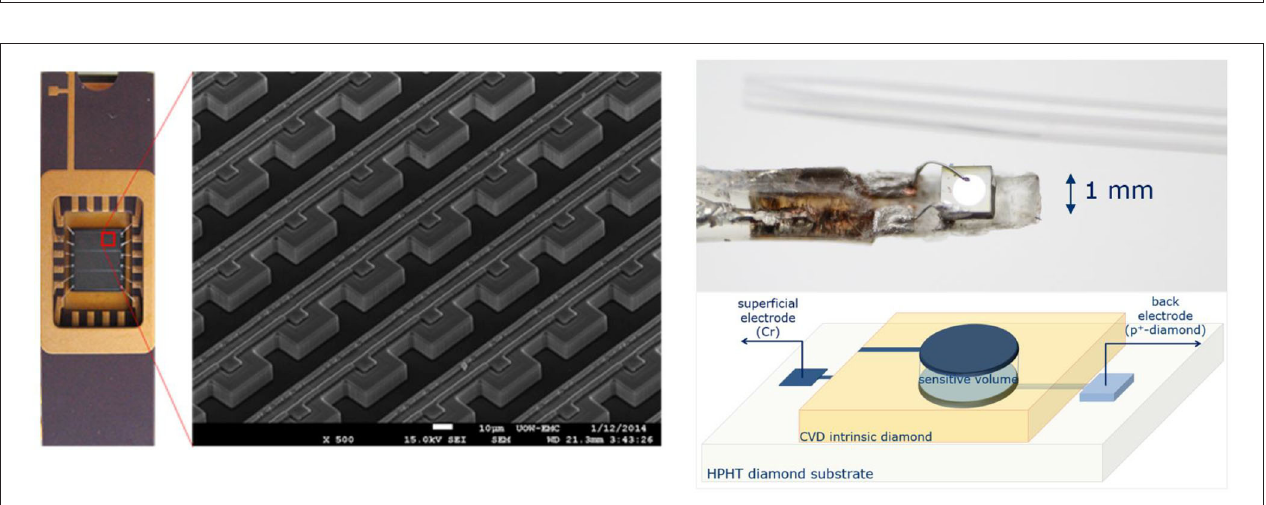
and can be used by clinicians to adapt the absorbed dose data in therapeutic plans. This process would result in a decrease of the absorbed dose at distal